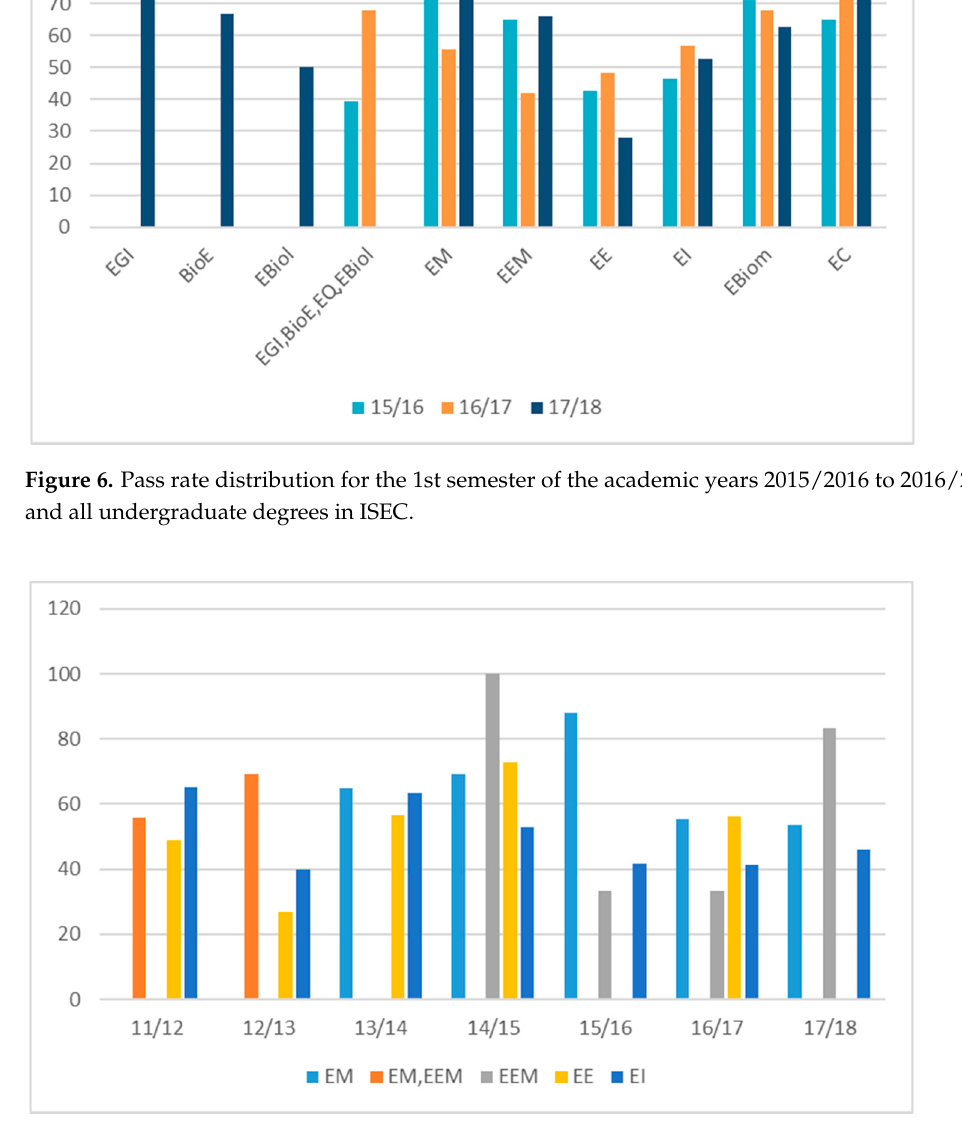
Figure 7. Pass rates distribution (2nd semester).